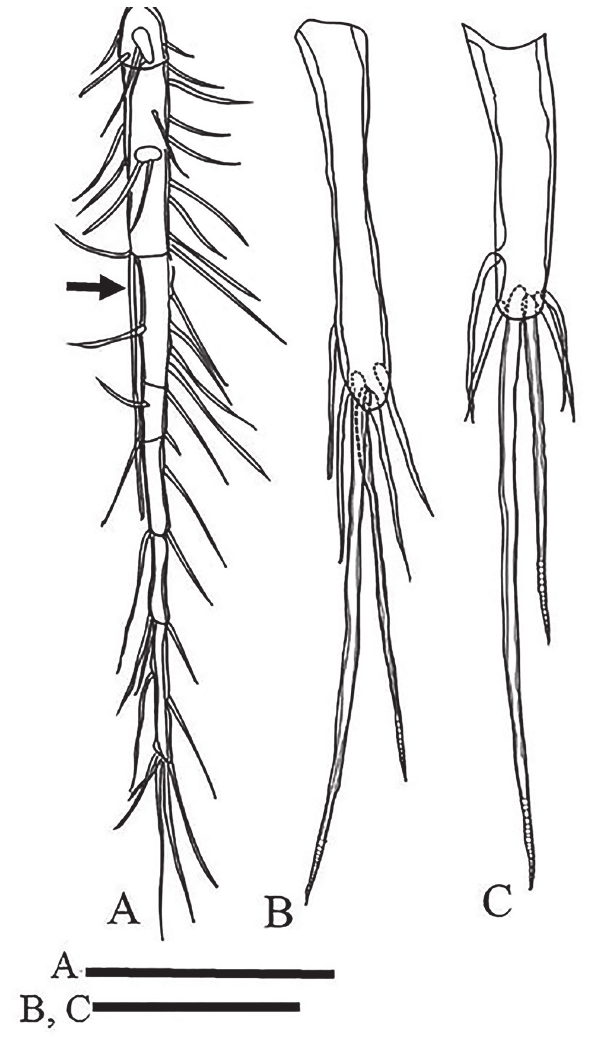
Figure 2. Clausidium persiaensis sp. nov. (female). A, antennule; B, caudal ramus; C, caudal rami (male). Scale bars: A, 50 μm; B, C, 25